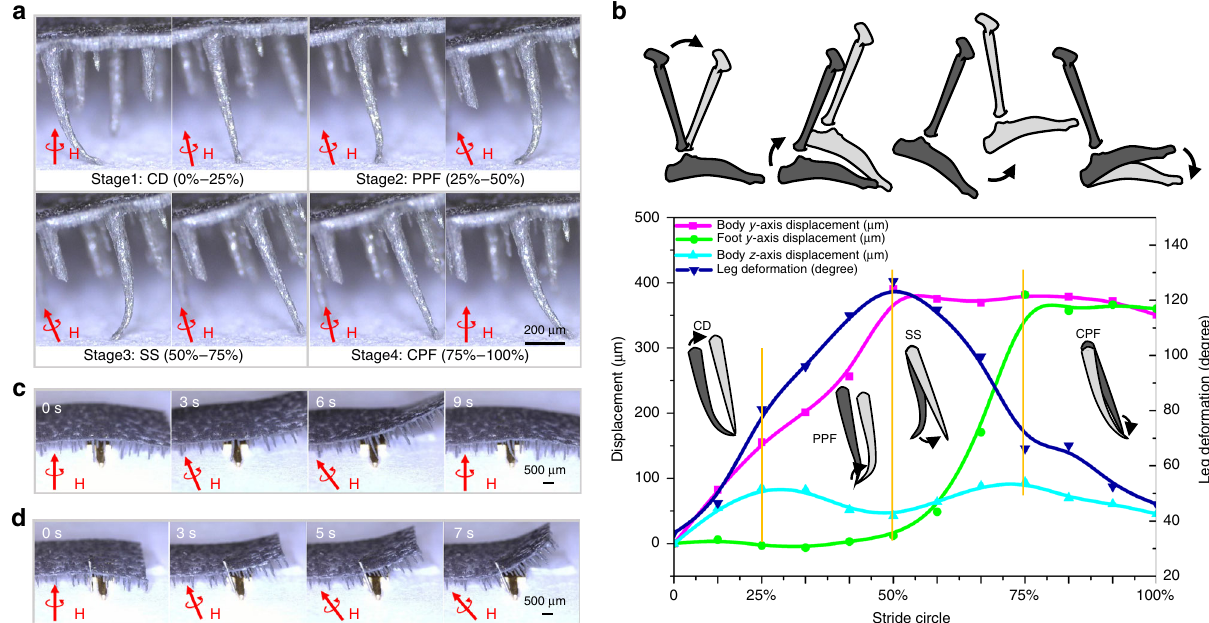
Fig. 3 Individual foot ’ s performance in one gait cycle. a Snapshots of an individual foot ’ s deformation in one gait cycle, which can be divided into four typical stages: controlled dorsi fl exion (CD), power plantar fl exion (PPF), swing state (SS), and controlled plantar fl exion (CPF). b Locomotion curves, including the robot body ’ s displacement along y axis (pink square line), the foot ’ s displacement along y axis (green circle line), the robot body ’ s displacement along z axis (light blue regular triangle line), and the foot ’ s deformation (dark blue inverted triangle line). The robot can maintain a smooth transition among four different stages in each gait cycle, which is reminiscent of that of human being and overcome the singular point of the traditional robot with rigid legs. c , d The robot with fl exible feet (Fig. 3c) exhibits superiority in obstacle crossing relative to the counterpart with the rigid feet (Fig. 3d). When the robot is exposed to an obstacle (height 160 μ m × width 1 mm) on the way forward, it can stride via quick release of the stored elastic energy enabled by the feet deformation. In contrast, the robot decorated with rigid feet is always stuck by the obstacle, irrespective of the direction of the magnetic fl ux